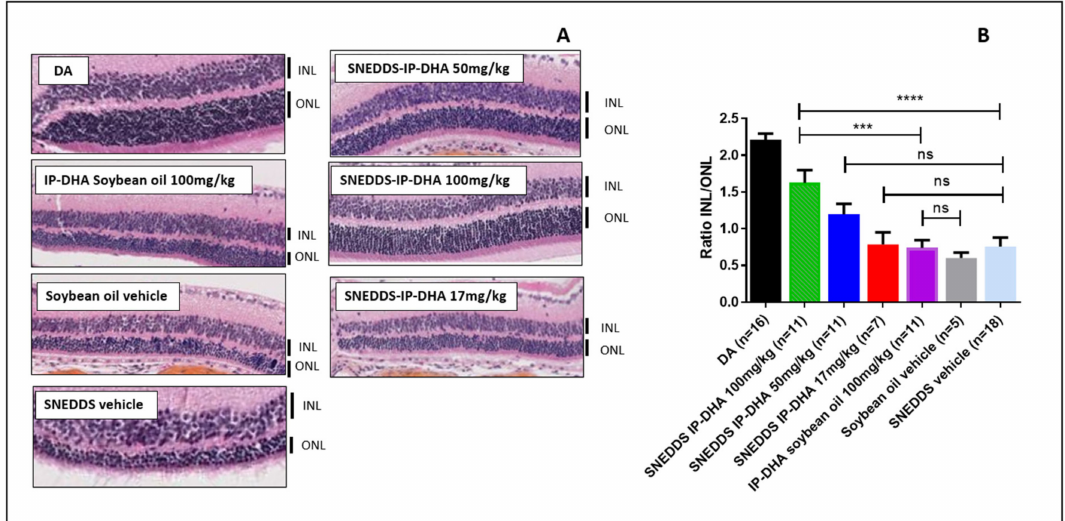
Figure 8. Images of histological analysis of ABCA4KO mice with various pretreatments after retinal degeneration induced by acute white light stress ( A ) and ratio of thickness of INL/ONL from this histological analysis ( B ). One-way ANOVA with Bonferroni’s multicomparison test: *** p < 0.001, **** p < 0.0001, ns: not